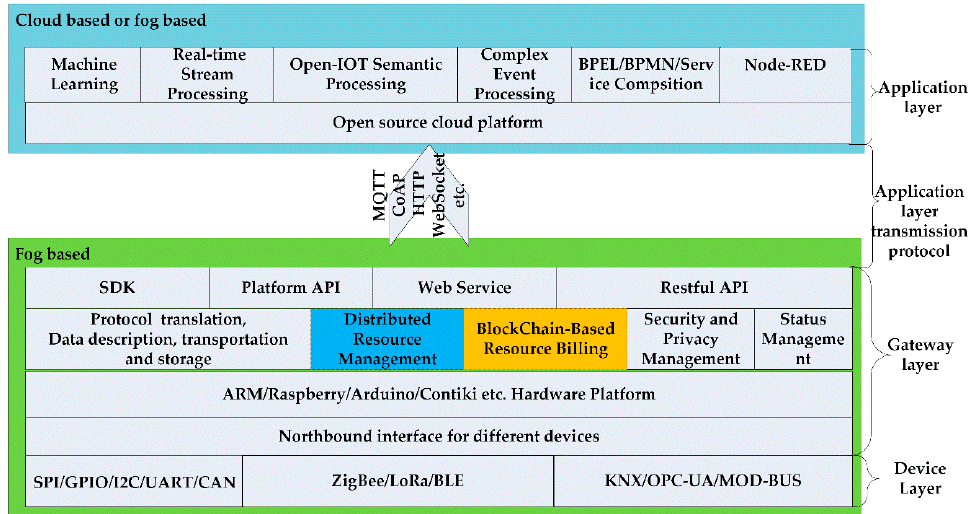
Figure 4. The IoT application development platform, based on open source technology.